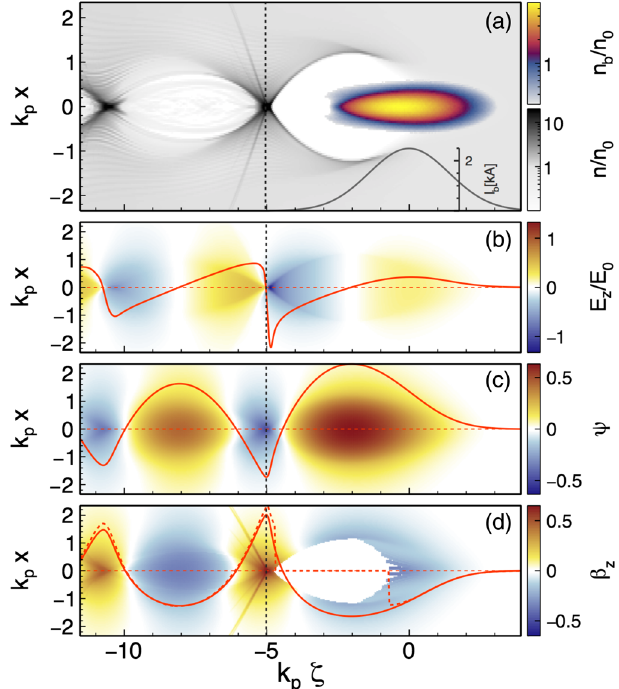
FIG. 3. OSIRIS 3D simulation of an axially symmetric Gaus- sian electron beam with peak current I 0 b ¼ 2 . 5 kA, transverse rms size k p σ r ¼ 0 . 3 , and longitudinal rms length k p σ z ¼ driver beam operates an uniform plasma at the resonant density. (a) Plasma ( n ) and beam ( n b ) electron density. (b) Longitudinal electric field ( E z ). (c) Wakefield potential ( ψ ). (d) Longitudinal electron velocity ( β z ). The solid curve in (d) represents β z as calculated from ψ according to Eq. (8) (with ϵ ¼ 1 ), while the dashed curve shows the value of β z retrieved from the